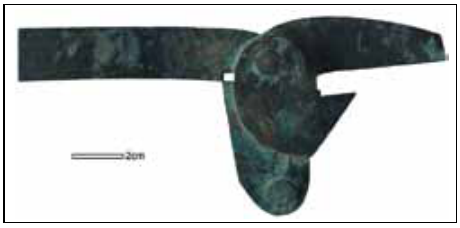
Fig. 6: A bronze crossbow trigger.